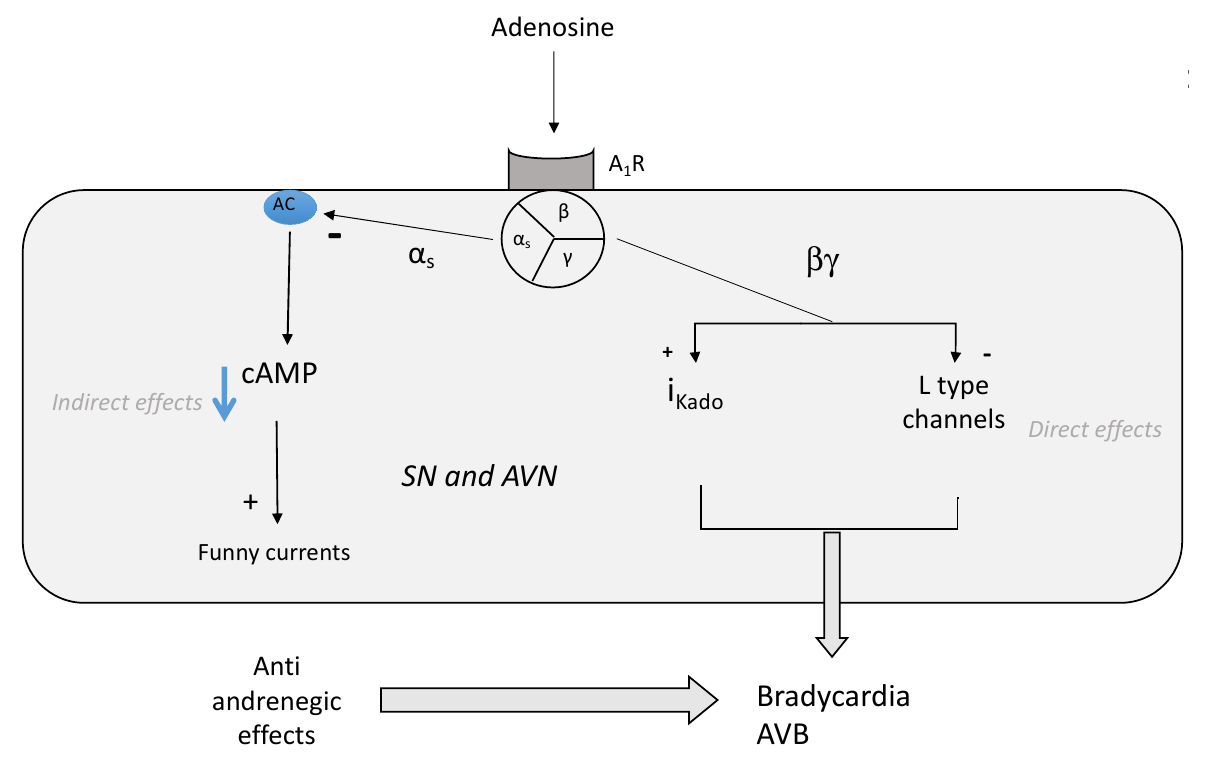
Figure 3. Effects of adenosine A 1 receptor (A 1 R) activation on sinus node (SN) and atrioventricular node (AVN). Binding of adenosine on A 1 R leads to the inhibition of adenyl cyclase (AC) and then decreases the production of cyclic AMP (cAMP, indirect effects) in opposition to the effects of the adrenergic system. The antiadrenergic effects occur via the activation of “funny” currents, which are mixed cAMP-dependent sodium/potassium inward currents. Via the βγ complex of the G protein (direct effects), adenosine binding to A 1 R leads to the activation of inward potassium channels (IK ADO ; inducing a hyperpolarization of the cell membrane and then inhibiting the synaptic transmission. The βγ complex of the Gi protein also acts on L-type calcium channels, leading to the inhibition of the calcium-dependent neuro-transmission. Both effects lead to bradycardia and sometimes atrioventricular block (AVB).